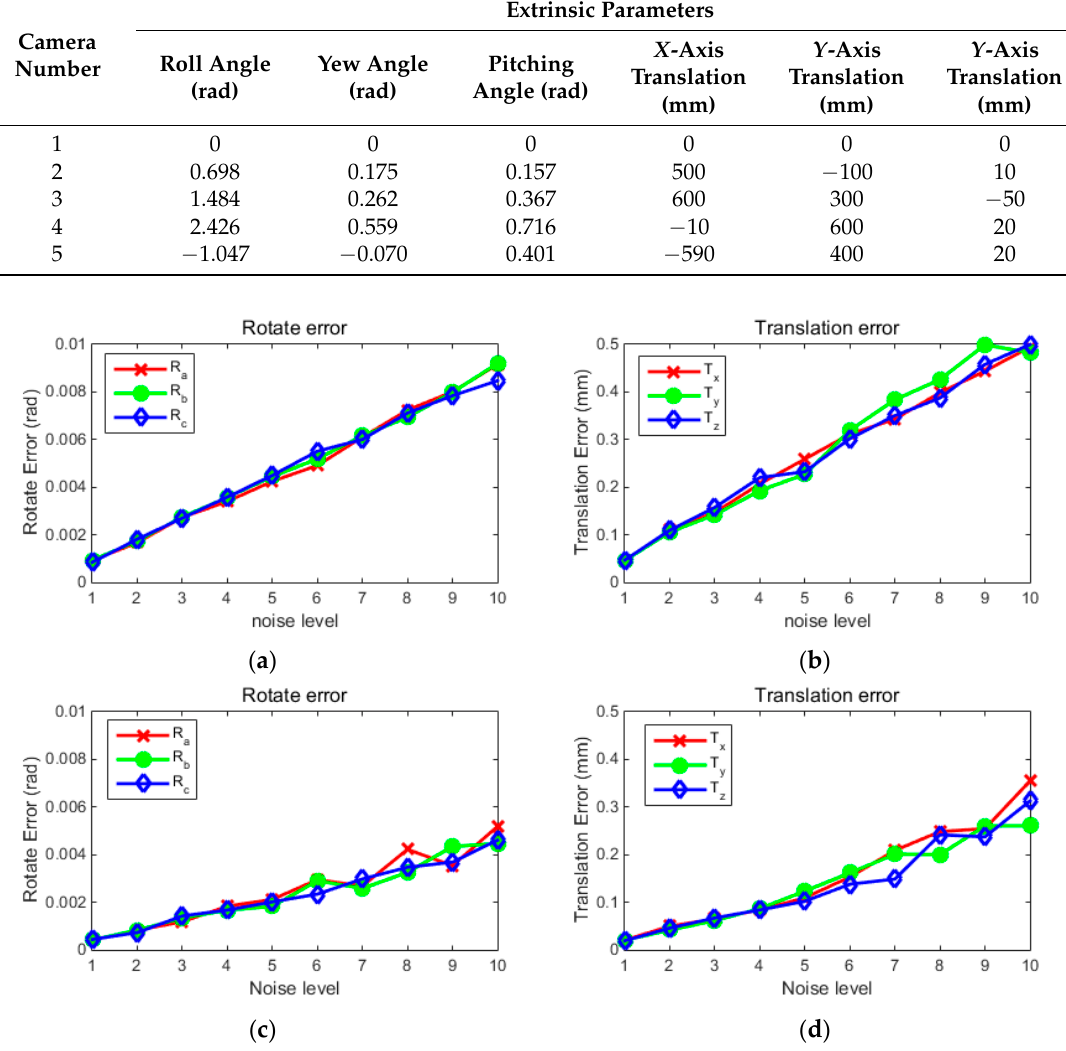
Figure 4. The extrinsic parameters’ RMS error curve of camera 3 before and after global optimization. The graph ( a ) shows the three rotation angle error curves obtained before optimization with ten noise levels. The graph ( b ) shows the translation error curve obtained before optimization with ten noise levels. The graph ( c ) is the rotation angle error curve after optimization with ten noise levels. The graph ( d ) is the translation error curve after optimization with ten noise levels.